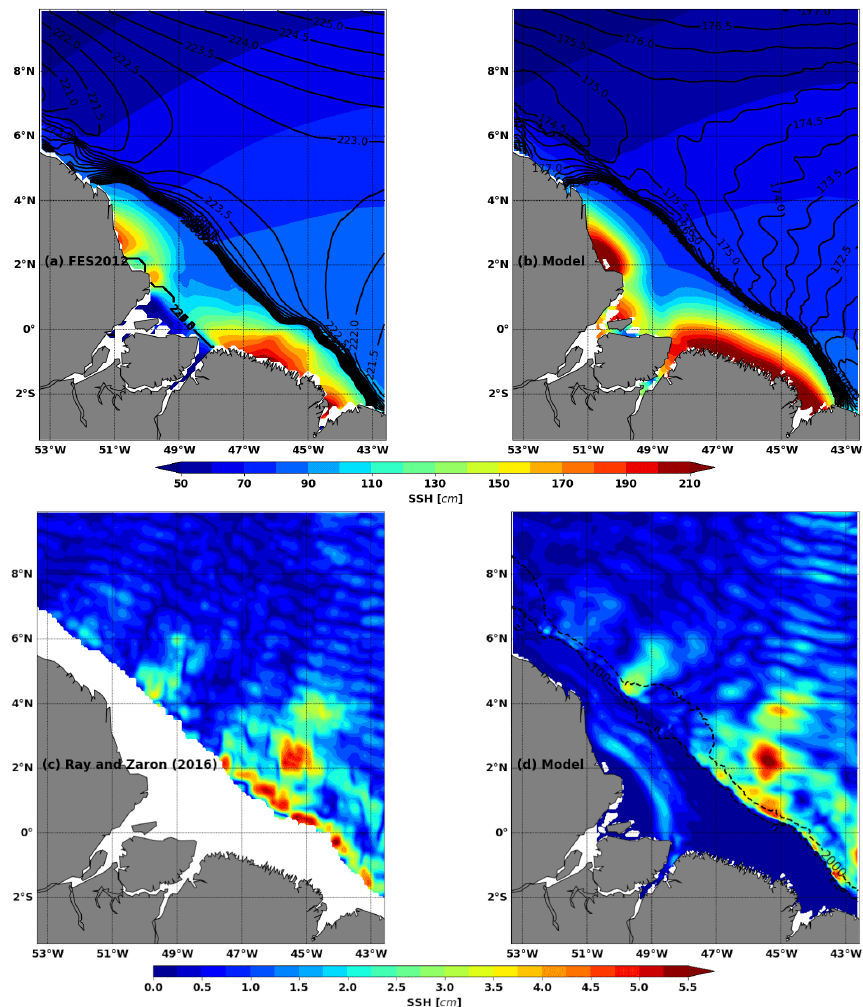
Figure 2. (a, b) M2 coherent barotropic SSH from (a) FES2012 (Carrère et al., 2012) and (b) the model. (c, d) M2 coherent baroclinic SSH from (c) altimetry by Ray and Zaron (2016) and (d) the model. Amplitude is in colour (unit: centimetres), and the phase is in solid black contours. Dashed blacks contours are 100 and 2000m isobaths. The models are based on the 9.5-month hourly